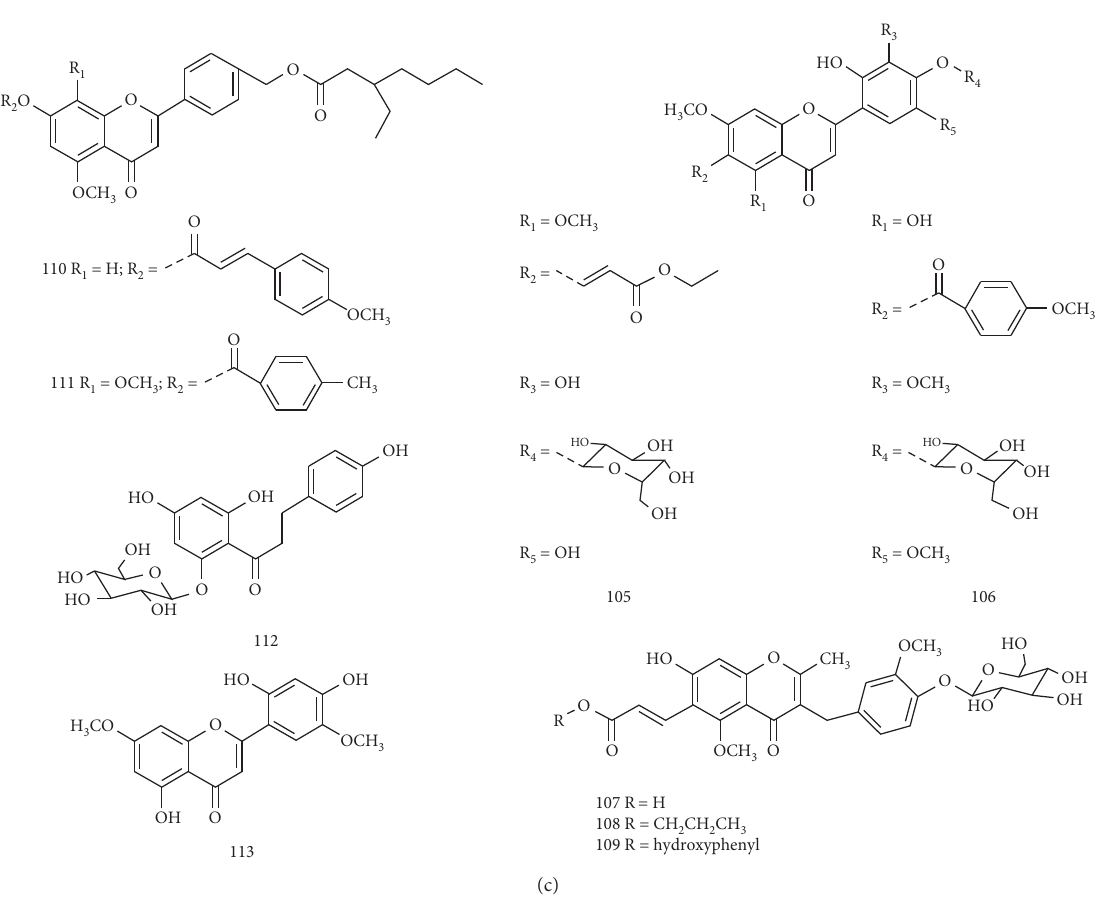
Figure 1: Chemical structures of flavonoids from Prunus